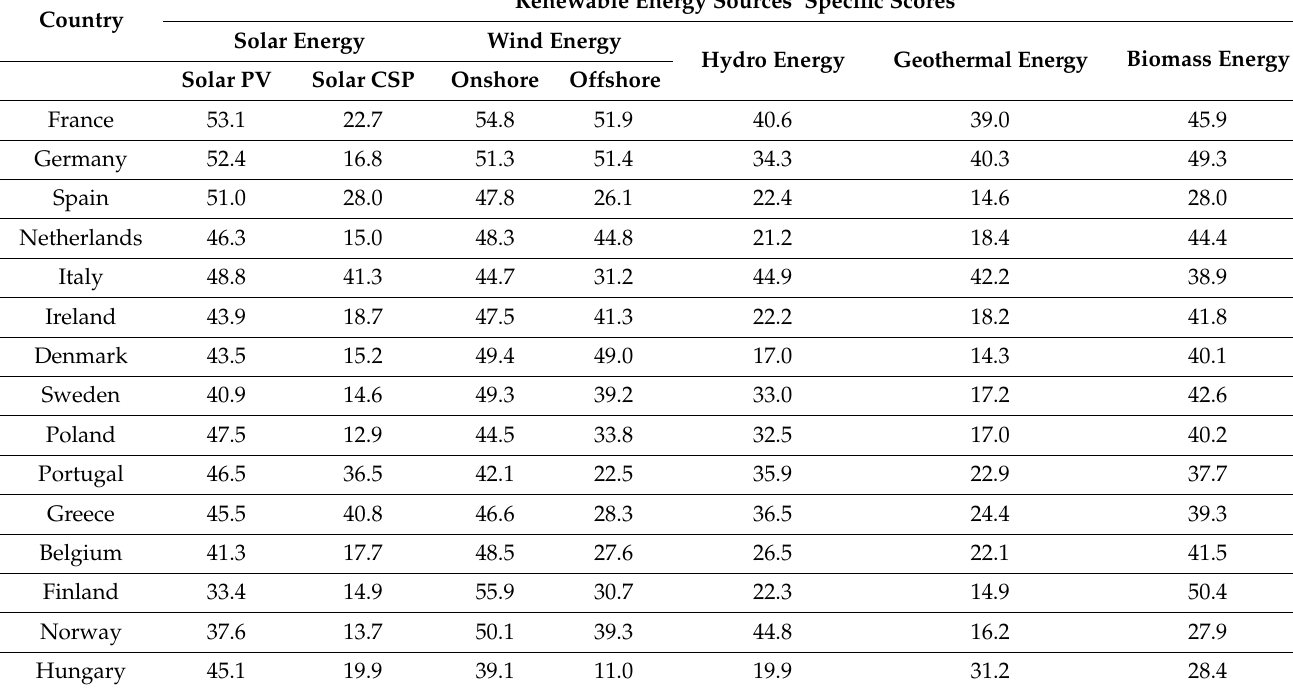
Table 2. EU renewable energy sources based on RECAI